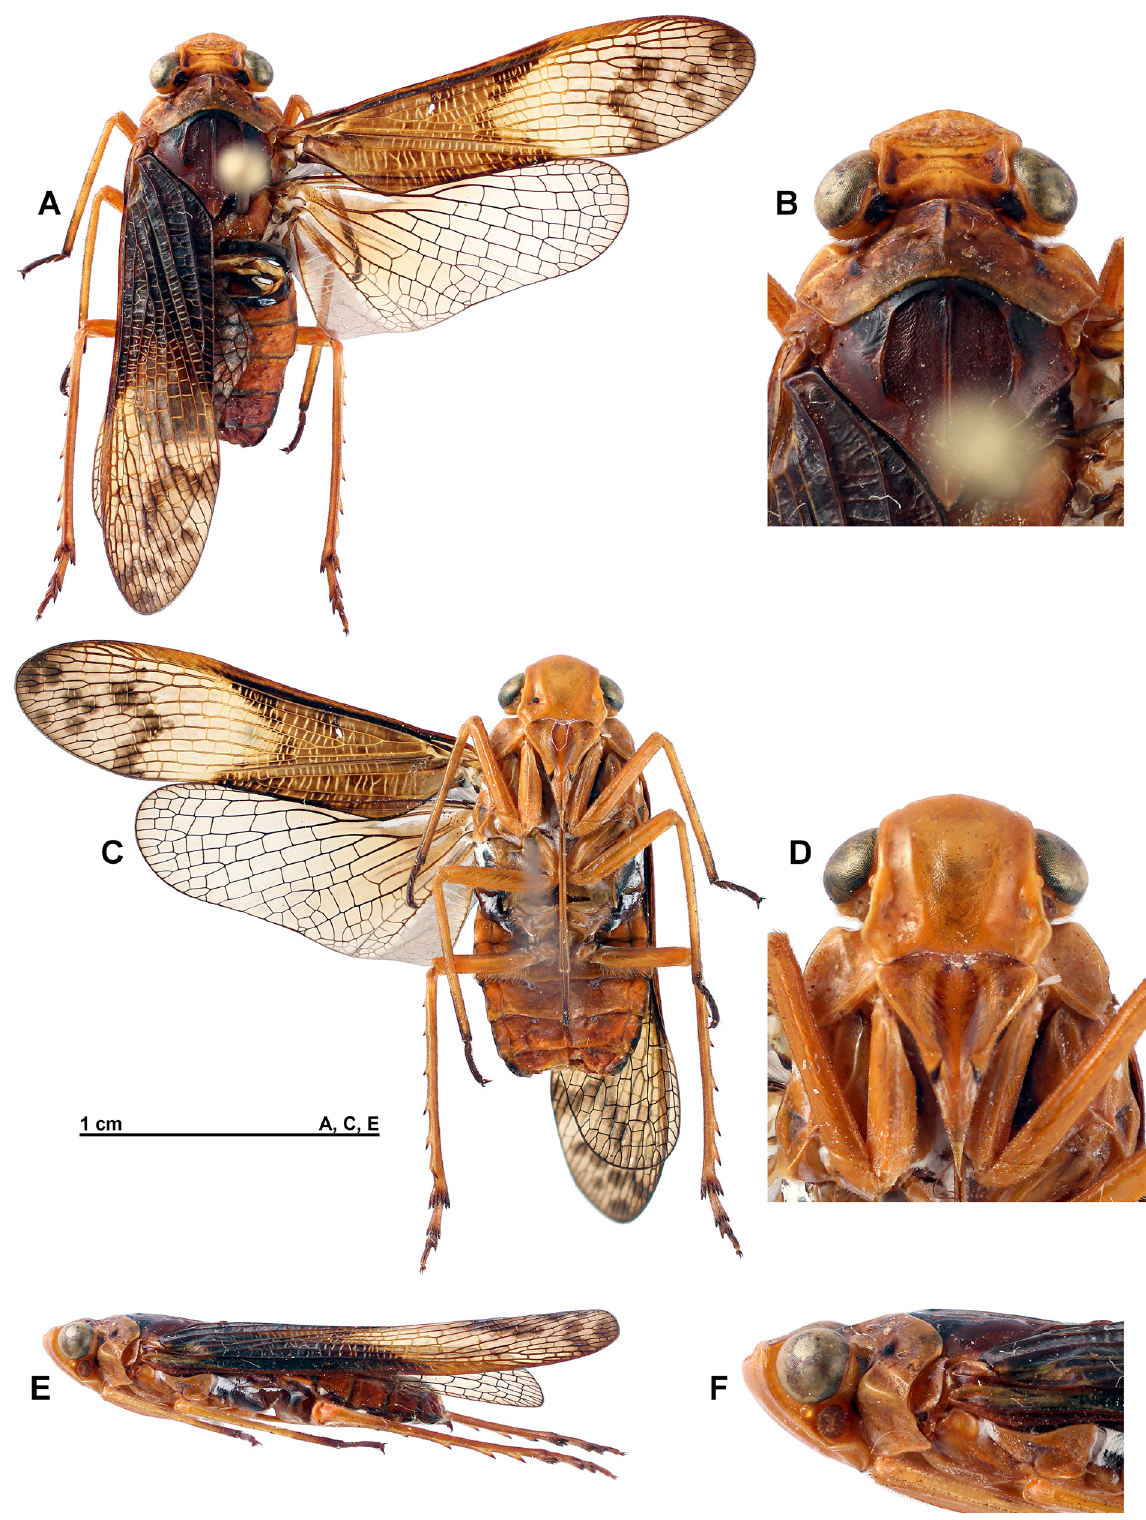
Fig. 1. Birdantis bhaskarai sp. nov., holotype, ♂. A . Habitus, dorsal view. B . Head and thorax, dorsal view. C . Habitus, ventral view. D . Head, normal view of frons. E . Habitus, lateral view. F . Head and thorax, lateral view. B, D, F not to